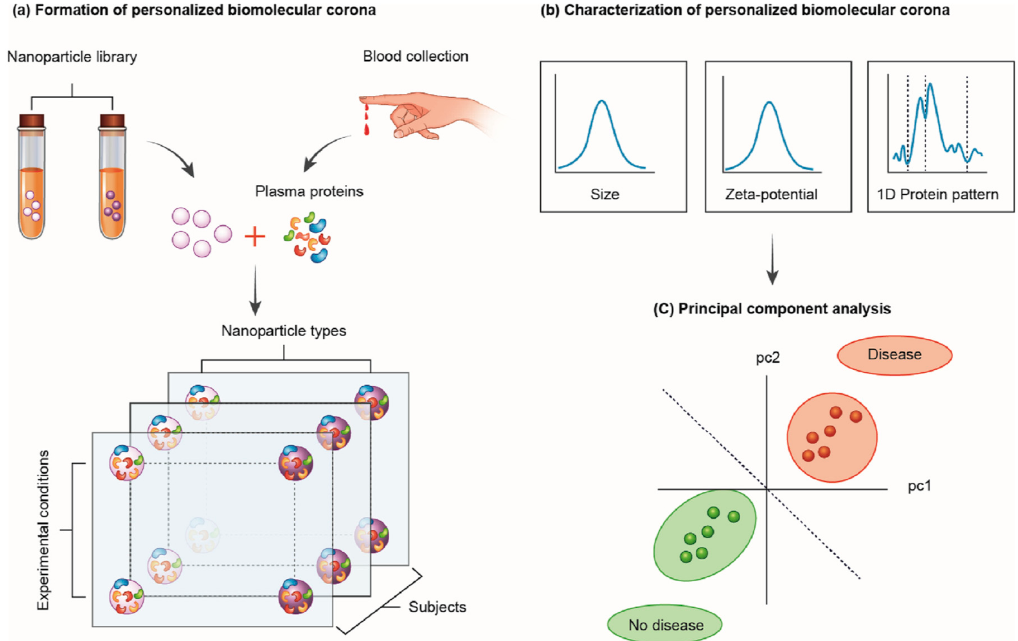
Figure 2. Nanoparticle-enabled blood tests for early cancer detection. ( a ) Nanoparticles are incubated with human plasma collected from cancer patients and healthy subjects. ( b ) A library of nanoparticle-protein complexes is generated by exposing different NP types (e.g., gold NPs, GO nanoflakes, liposomes, lipid NPs, etc.) with different physical-chemical properties (e.g., size, aggregation state, shape, surface charge, etc.) to HP under different experimental conditions such as protein concentration, NP/protein molar ratio, temperature, shear stress, etc. This practice results in the development of a big data set of “personalized protein coronas”. ( c ) For each corona, several physical-chemical parameters are collected.The data set is compacted by principal component analysis (PCA) into a series of new variables (PC1, PC2, etc.). Cancer patients and healthy volunteers give rise to two well-separated clusters in the principal components’ Cartesian plane (“disease” vs. “no disease”). Reprinted with permission from Elsevier from Nano Today , 21, 14–17. (2018), M. Papi and G. Caracciolo. Principal component analysis of personalized biomolecular corona data for early disease detection [4].